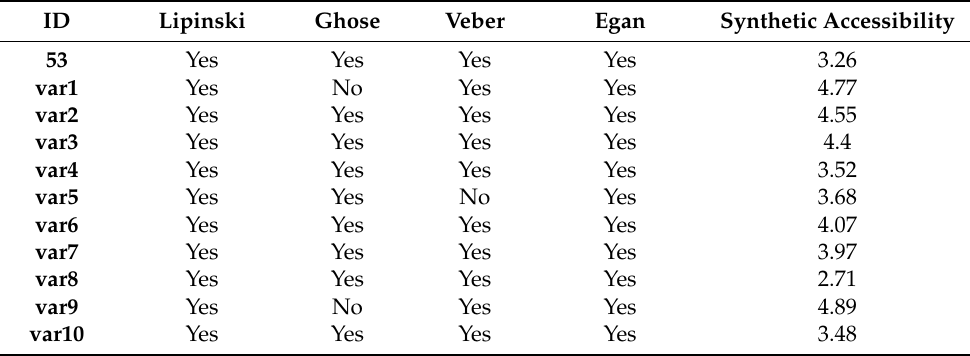
Table 6. Drug likeness of novel designed molecules based on Lipinski, Ghose, Veber, and Egan rules, and their synthetic